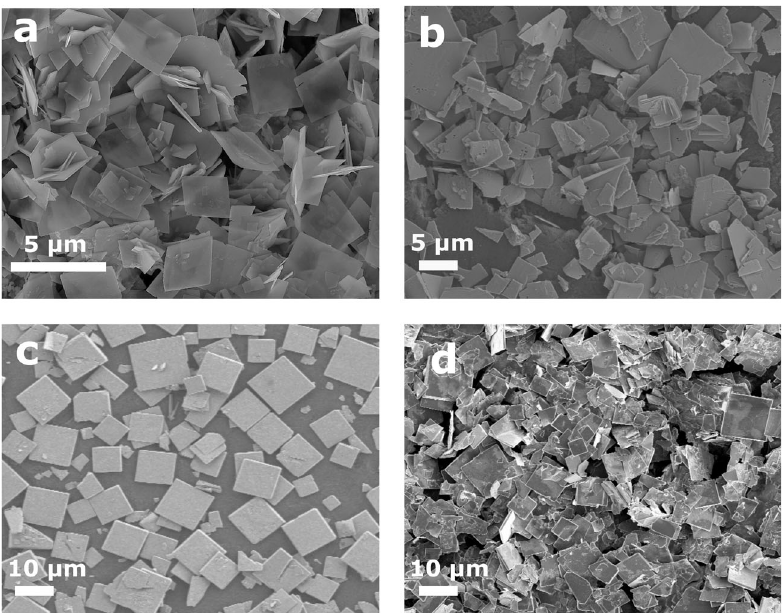
Fig. 3 SEM micrographs of the SnO samples produced in the methanol:water mixtures in different ratios. a 70:30, b 50:50, c 30:70 and d